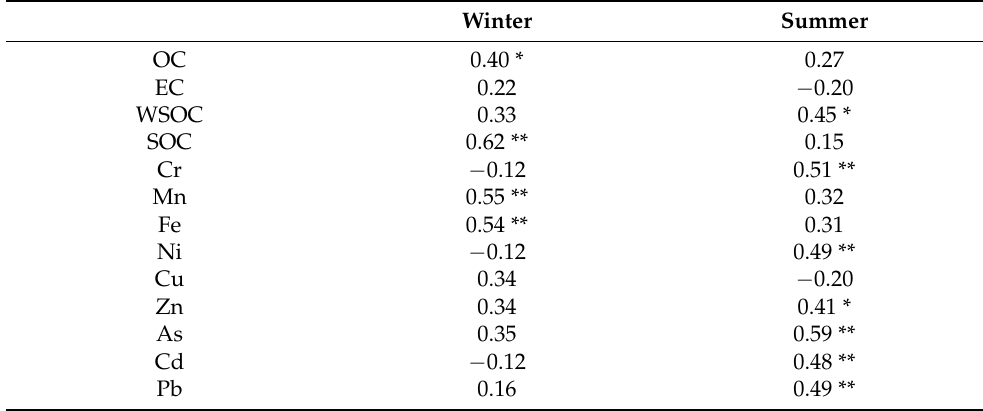
Table 3. Correlation coefficient (R) of volume-normalized OH radical (OH v ) with chemical compo- nents of PM 2.5 in Lahore during winter and summertime sampling, 2019. Winter